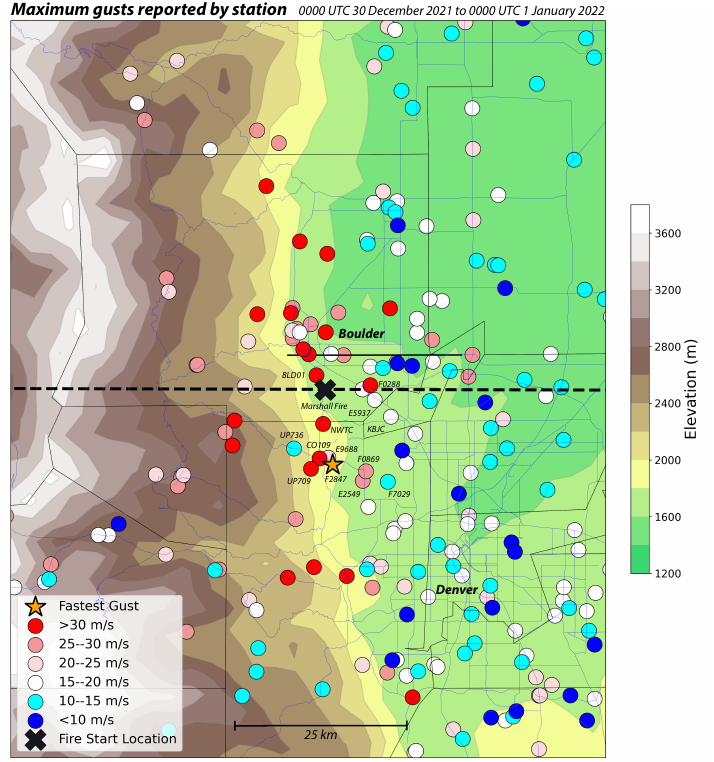
Figure 1. Maximum gusts reported between 0000 UTC 30 December 2021 and 0000 UTC 1 January 2022, from observations obtained from MADIS, on HRRR model topography. Stations missing from MADIS (except for station ‘NWTC’) or not reporting gusts are not shown. Observations deemed suspect excluded. Horizontal black dashed line depicts orientation (but not extent) of vertical cross-sections shown in this paper. Marshall fire ignition location adopted from